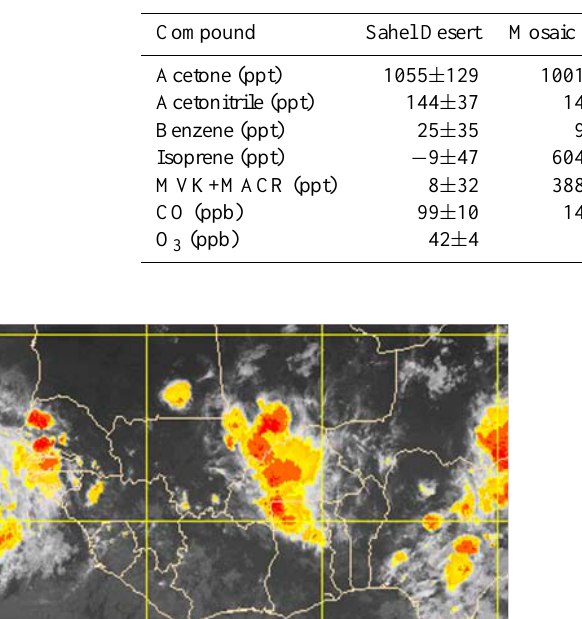
Table 1. Average mixing ratios ( ± one standard deviation) measured below GPS altitude of 700m over different surface types. The Sahel region encompasses measurements north of 13.8 ◦ N, the mosaic forest between 7.2 ◦ N and 13.1 ◦ N, and the ocean south of 6.4 ◦ N. Lagos air is selected from a single flight (B229), specifically when the aircraft was downwind of the urban area. Air considered to be influenced by Niamey was encountered shortly after takeoff and before landing on several flights, in the region between 13.1 and 13.8 ◦ N and between 1.9 and 2.4 ◦ E.